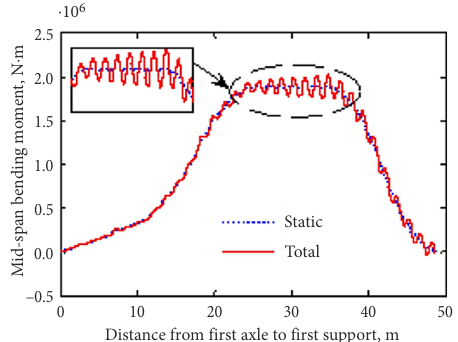
0.0 Distance from first axle to first support, m Figure 6. Maximum total and static component of bending moment at mid-span versus location of the first axle Figure 7. Individual contributions of each axle to total bending moment at 30.24 km/h